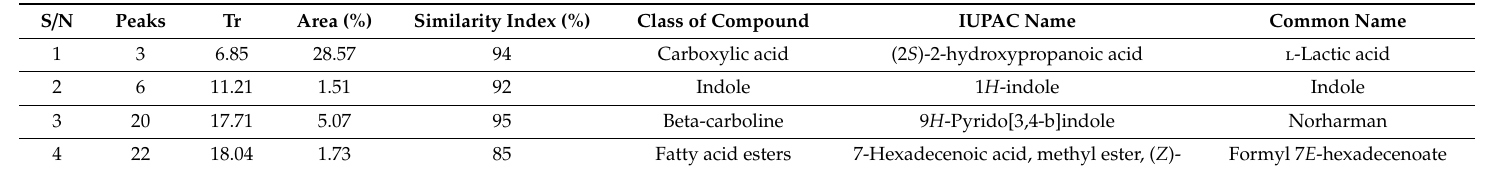
Table 2. Compounds present in the GC-MS analysis of the aqueous extract of fermented C. albidum